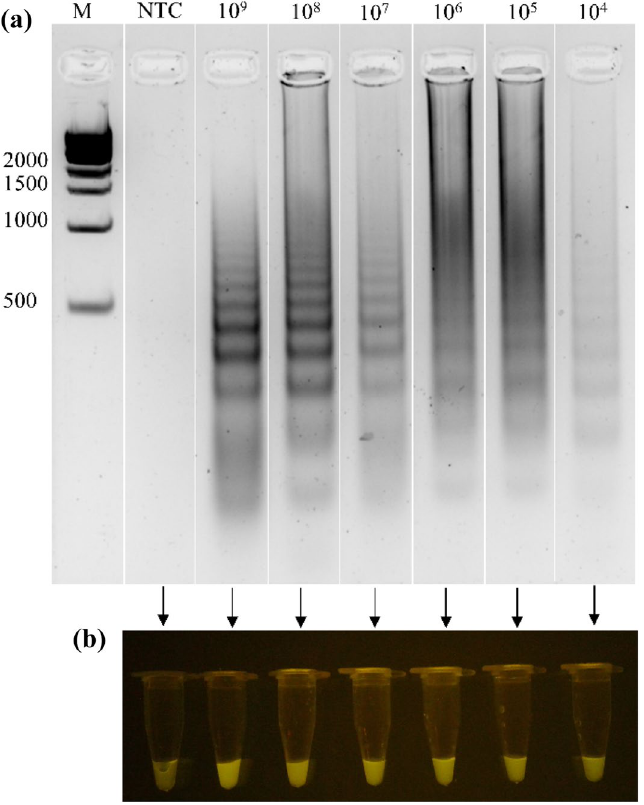
Figure 5. Sensitivity of LAMP in milk samples. ( a ) LAMP products visualized in 2% agarose gel. DNA size marker is shown in leftmost lane; and a no template control (NTC) is shown in rightmost lane. “M” indicates “molecular-weight size marker.” ( b ) LAMP amplification products with SYBR safe as a dye observed under blue light from milk samples contaminated at several concentrations of S. aureus (10 9 –10 4 CFU/mL).